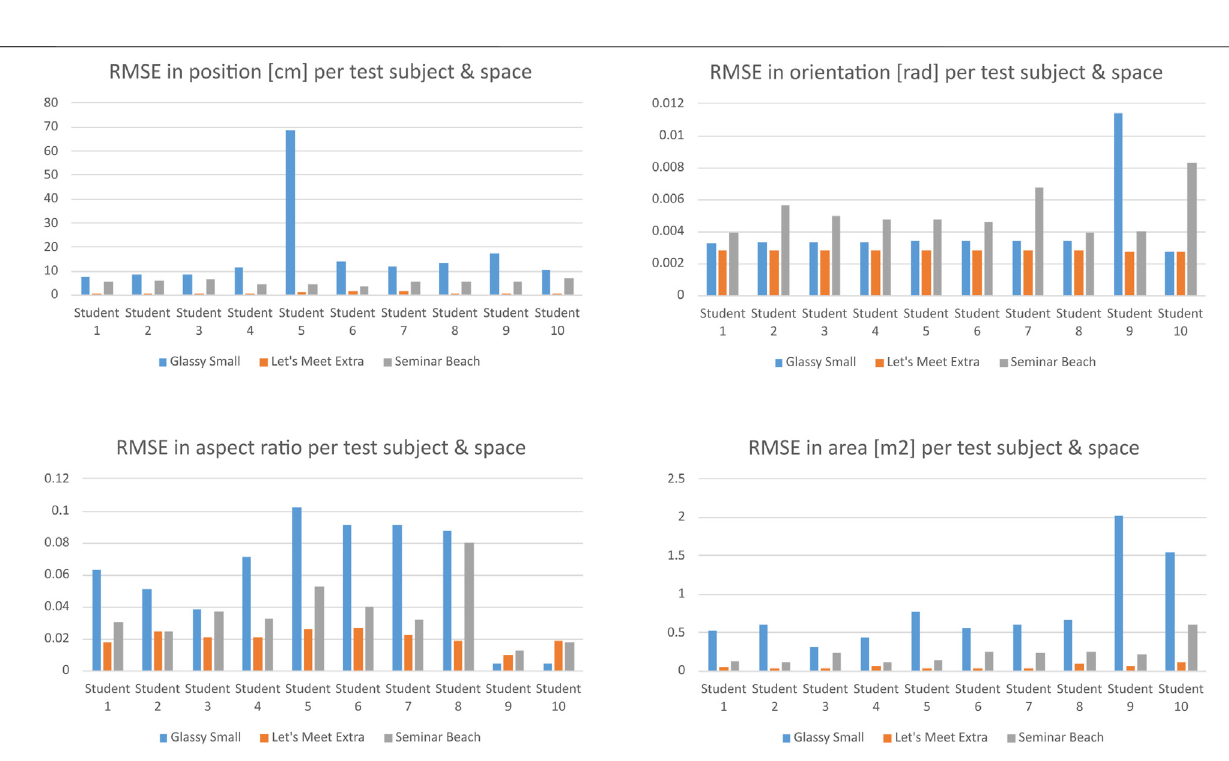
Frontiers in Computer Science |